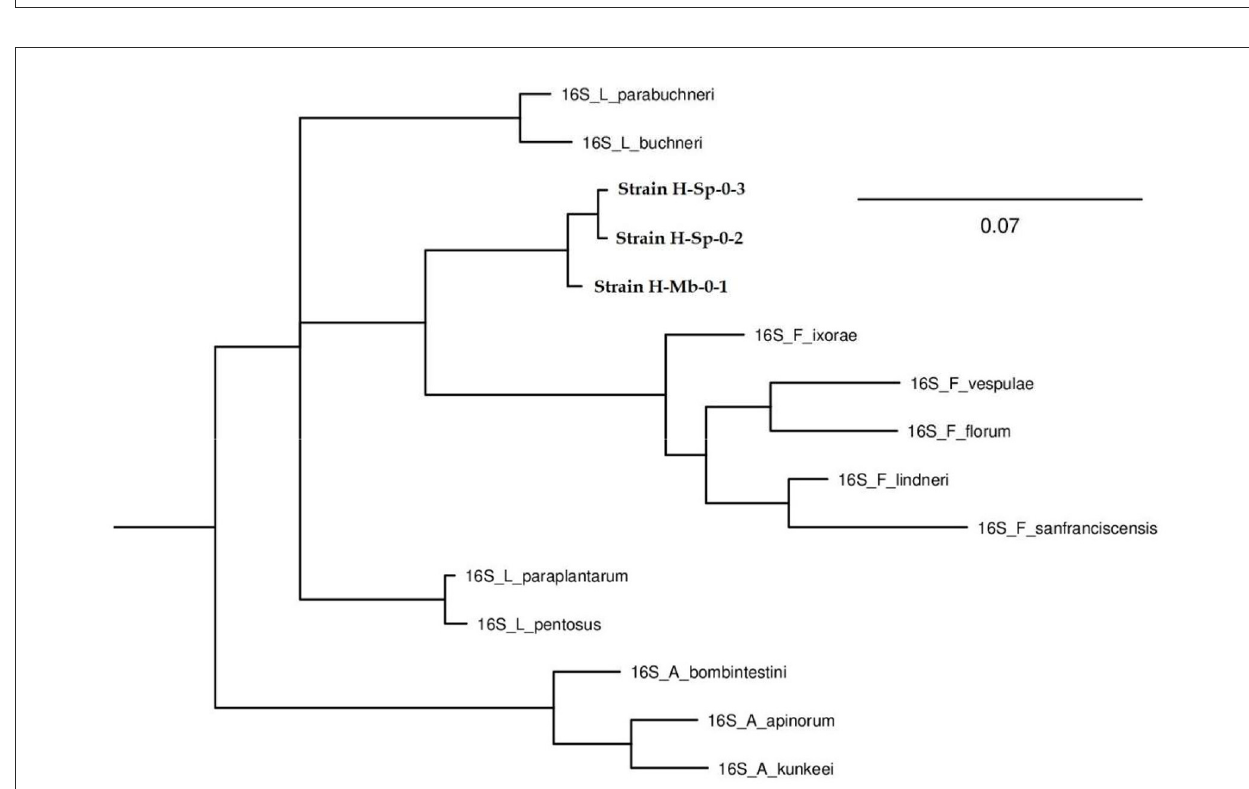
FIGURE5 Phylogenetic tree of the strains found in honey belonging to the genus Fructilactobacillus (H-Sp-02, H-Sp-03, and H-Mb-01).